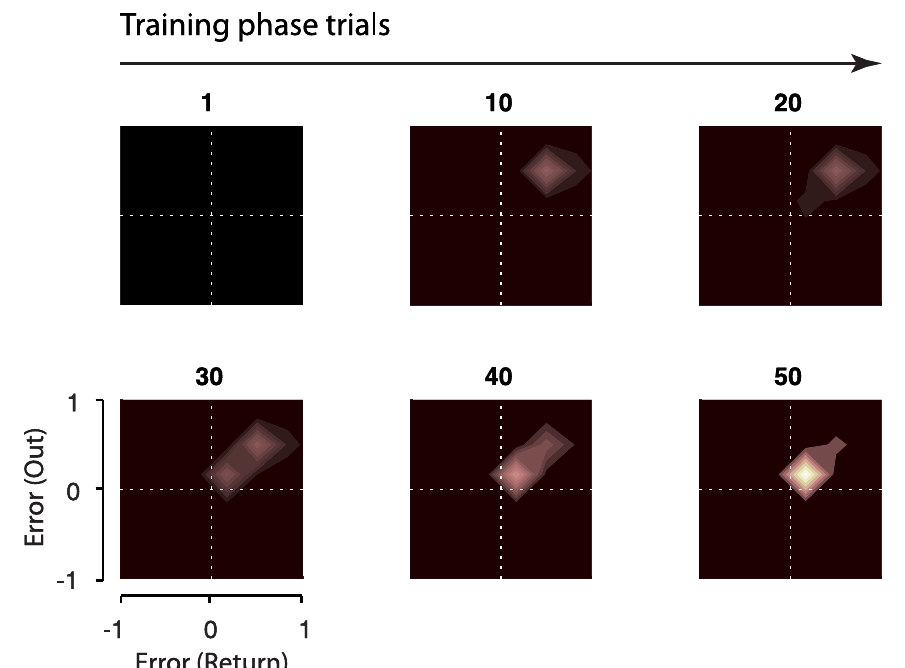
Fig 9. The coupling matrix. The coupling matrix for model M8 is shown for selected trials during the Training phase experienced by G1 to G4 (Training phase was identical for these groups). Before experiencing any errors, all elements of the matrix are zero (Trial 1). The force field is then experienced on both Out and Return movements, resulting in the development of coupling between the corresponding errors (both positive errors). Early in Training phase (trials 10 and 20), there are large errors and the coupling matrix accumulates a weighting away from the origin. As adaptation progresses (trials 30 to 50) the errors reduce. As a result, the coupling shifts towards the origin and increases. The coupling matrix for G5 (not shown) remains unchanged (as in Trial 1) throughout the Training phase as errors are only experienced on the Out movements.